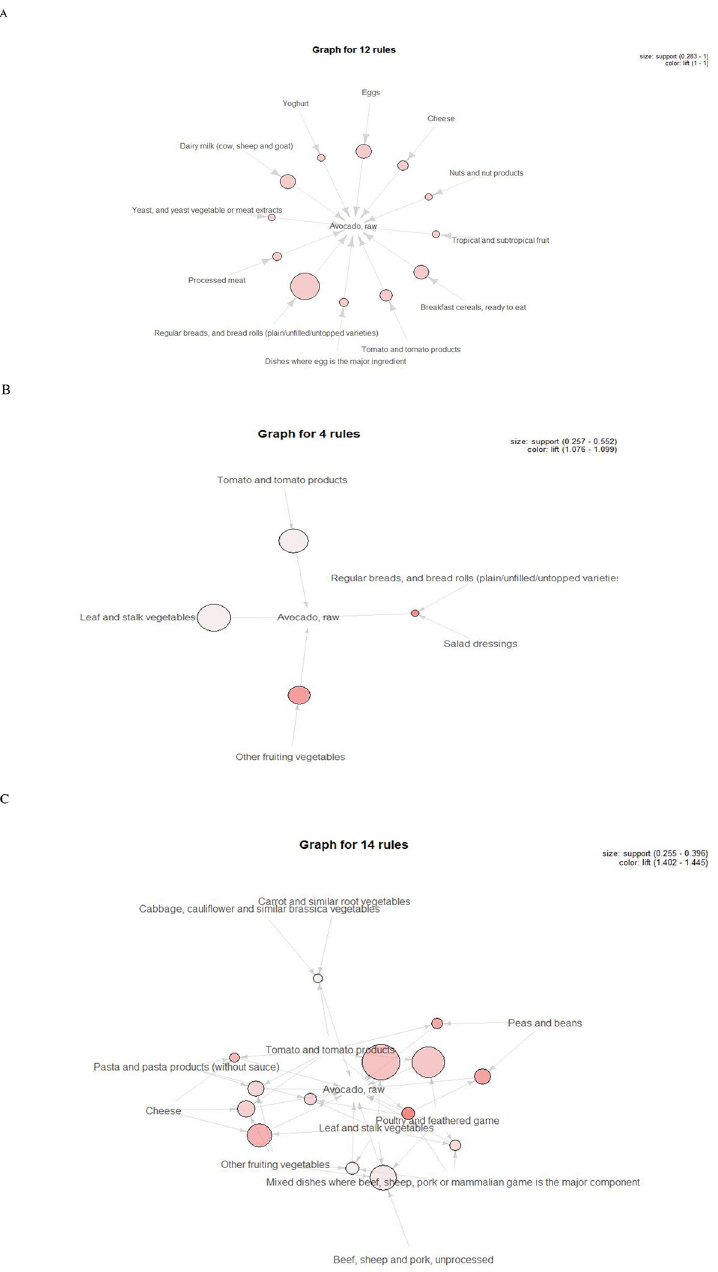
Fig 1. Visualization of the food choice associations with avocados at the sub-major food group level A. Breakfast (n = 12). B. Lunch (n = 4). C. Dinner (n = 14). Arrows represents closely related food groups relationships. The size of the sphere shows the value of support. The intensity of the colour indicates the value of